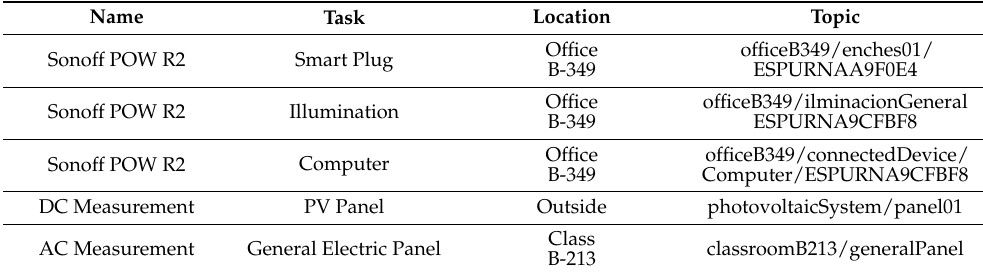
Table 4. Description of topics connected to